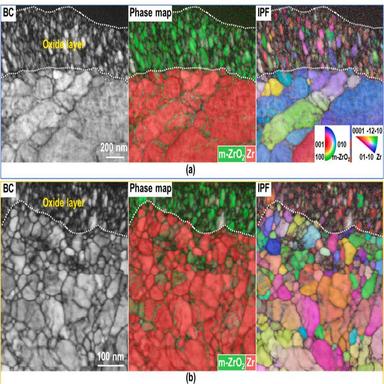
Cross-sectional TKD band contrast map, phase map, and inverse pole figure maps of the (a) unworn and (b) worn areas on the uncoated cladding.